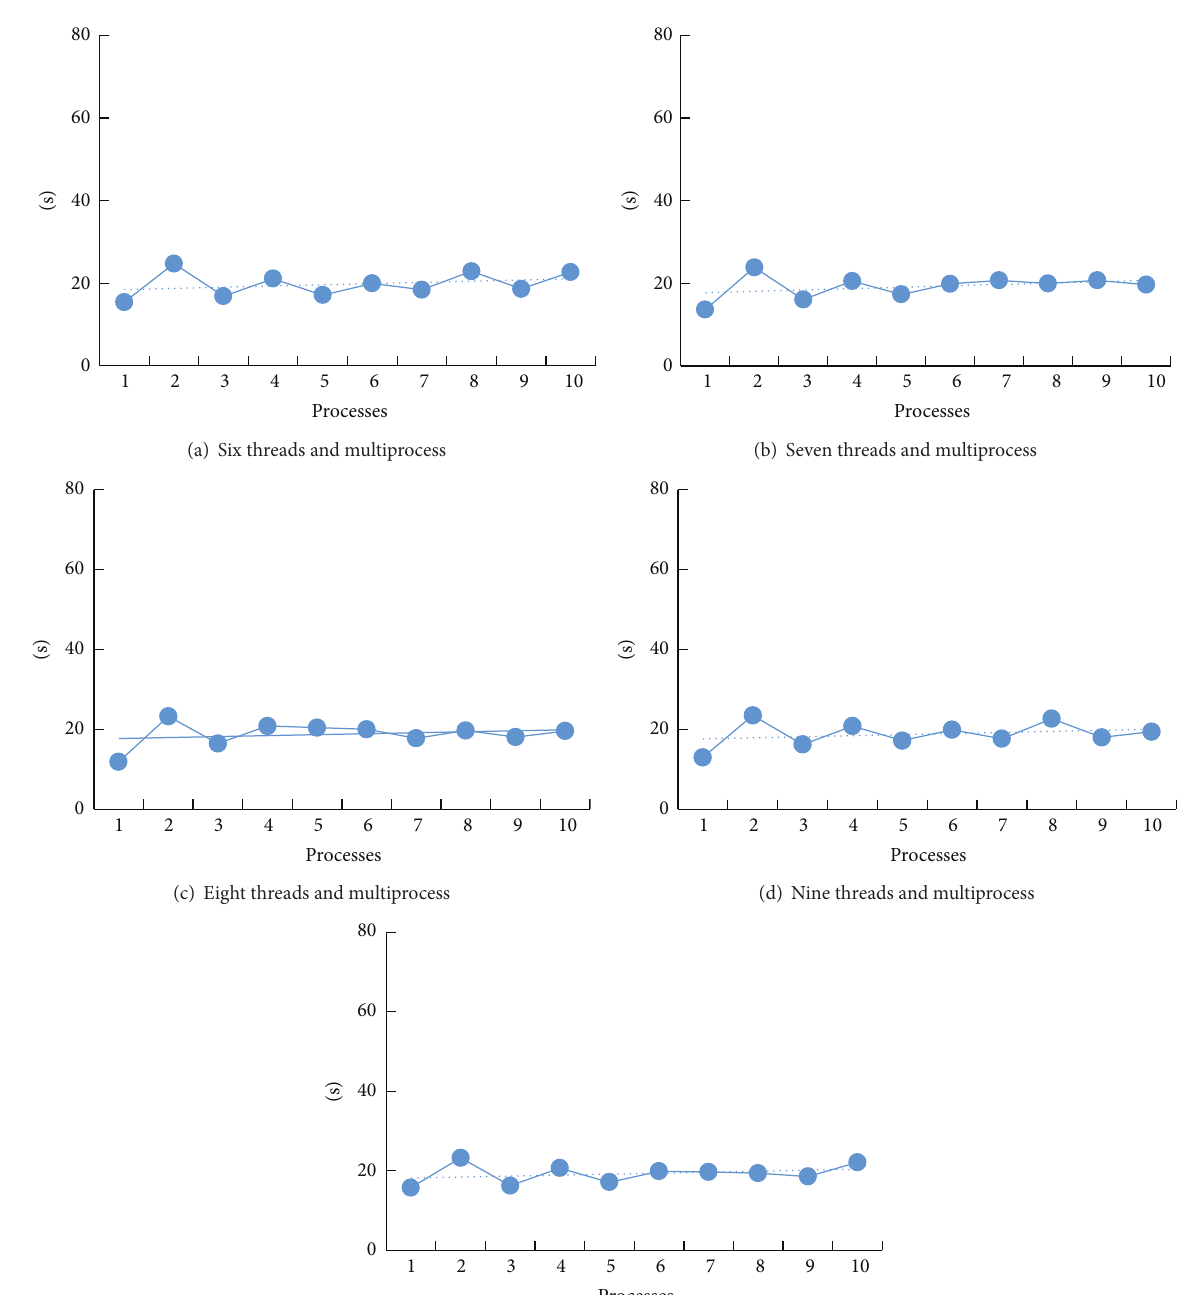
Figure 5: Algorithm speed and its relation to the number of processes and 6–10